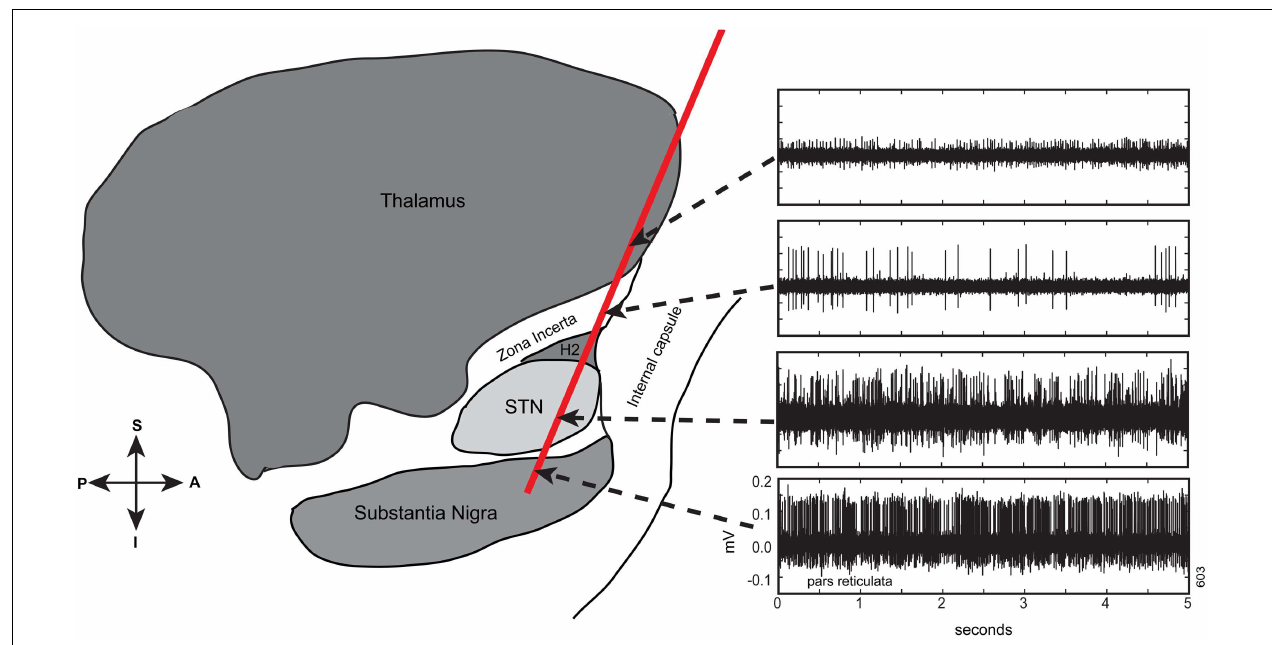
passing from thalamus to Zi through STN to substantia nigra (pars reticulata). Note that the qualitative activity along the pass is not different from what is encountered when targeting during later-stage PD [e.g., Ref. (3)]. Pass superimposed on a sagittal schematic adapted from Schaltenbrand andWharen (16).